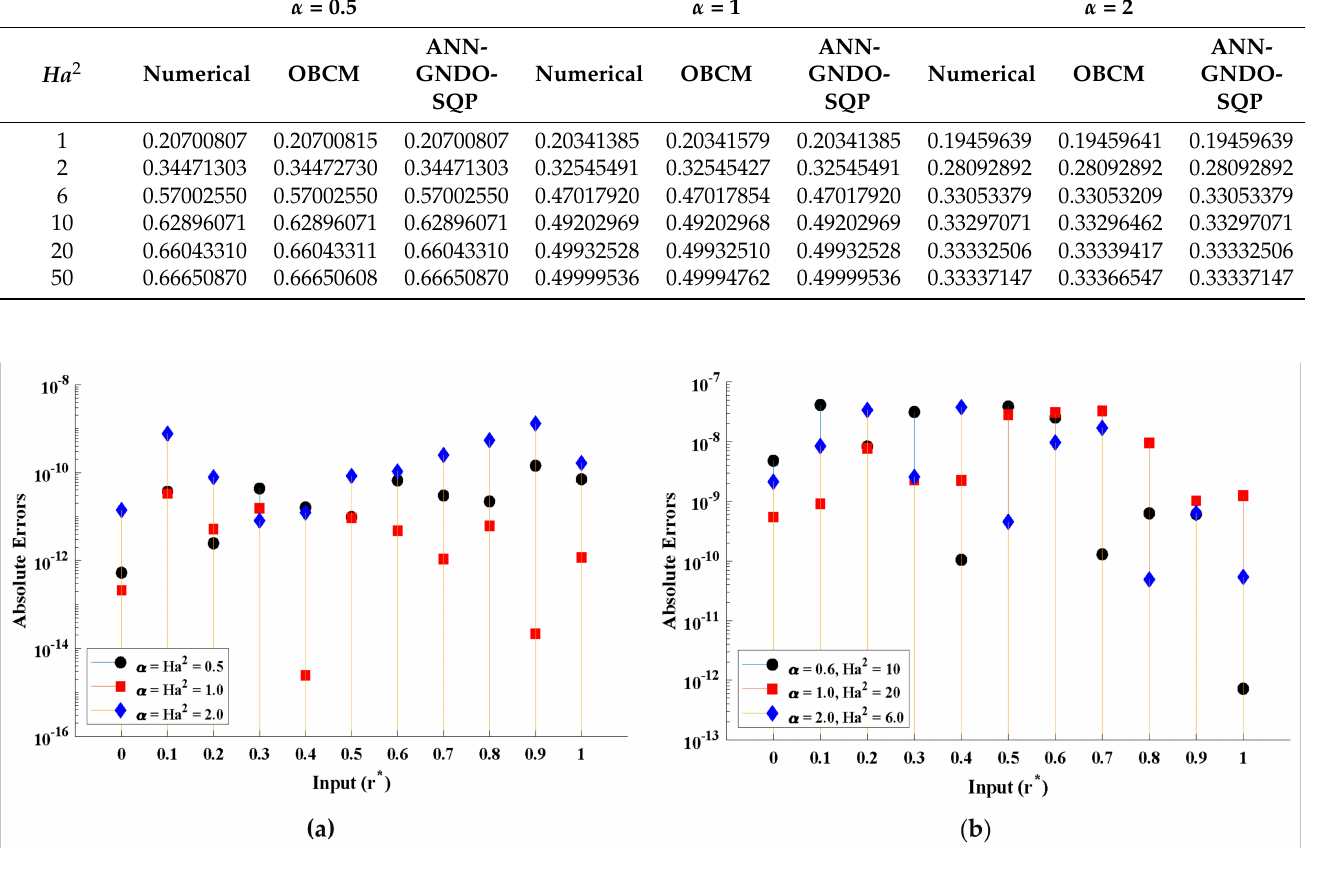
Figure 6. Absolute errors in our solutions obtained by the proposed algorithm for calculating w ∗ ( r ∗ ) of the EHD flow of fluid for ( a ) same values of parameters and ( b ) different values of nonlinearity parameter and Hartmann electric. Table 5. Comparison of absolute errors in our solutions obtained by the ANN-GNDO-SQP algorithm with the orthogonal Bernstein collocation method [20] and the least square method